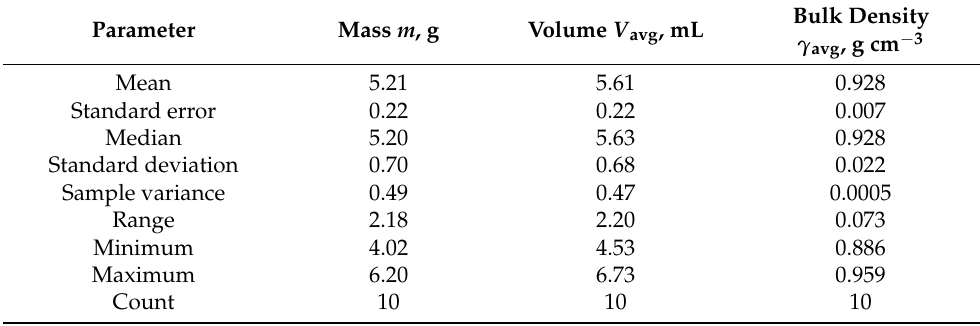
Table 3. The hundred-granule sample mass, volume, and bulk density for the Agro NPK fertilizer.